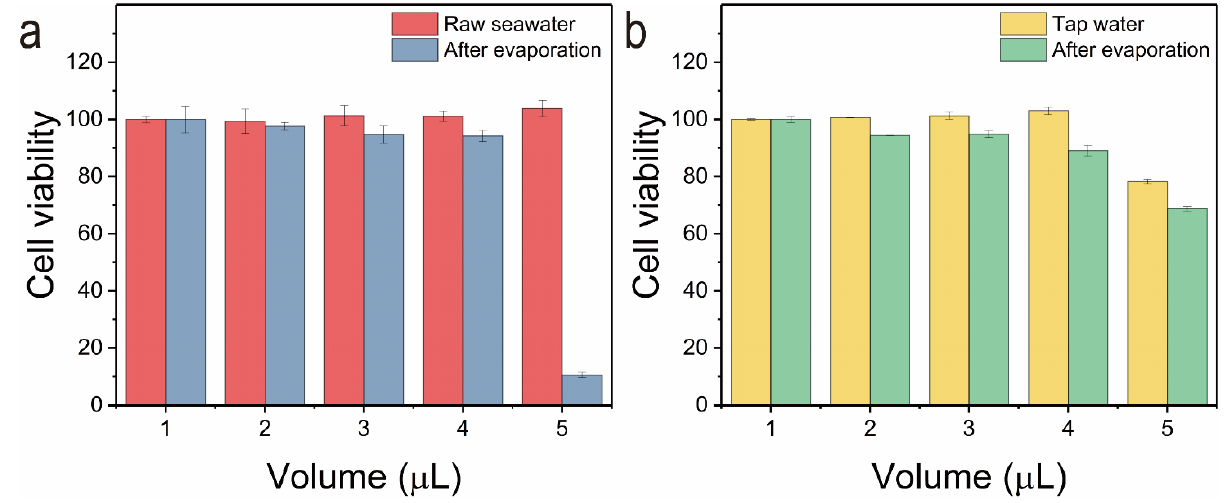
Figure 14. ( a , b ) Cell activity before and after seawater and tap water treatment.